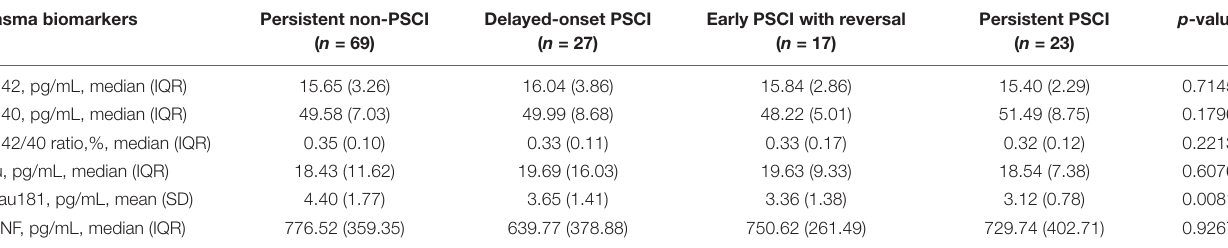
TABLE 4 | Association between plasma biomarkers and different persistent cognitive impairment statuses according to CDR-SB at 3 and 12 months. Plasma